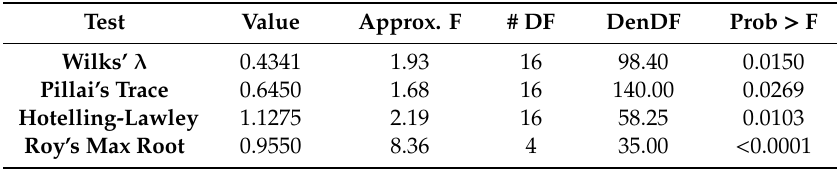
Table 2. Significance of canonical correlation analysis (CCorA)